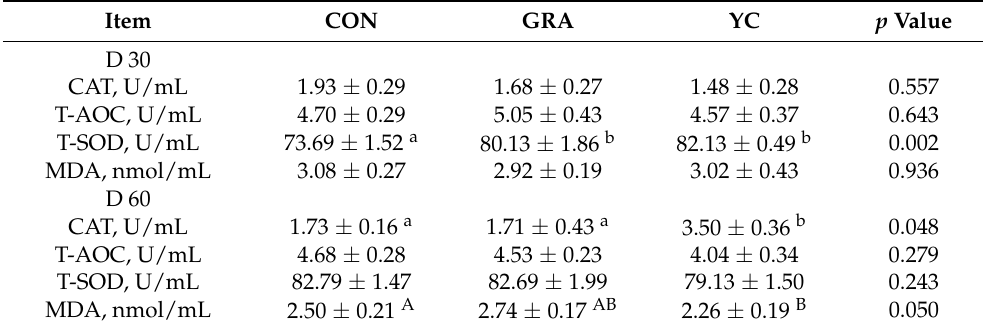
Table 7. Effect of dietary yeast culture supplementation on antioxidant capacity of finishing